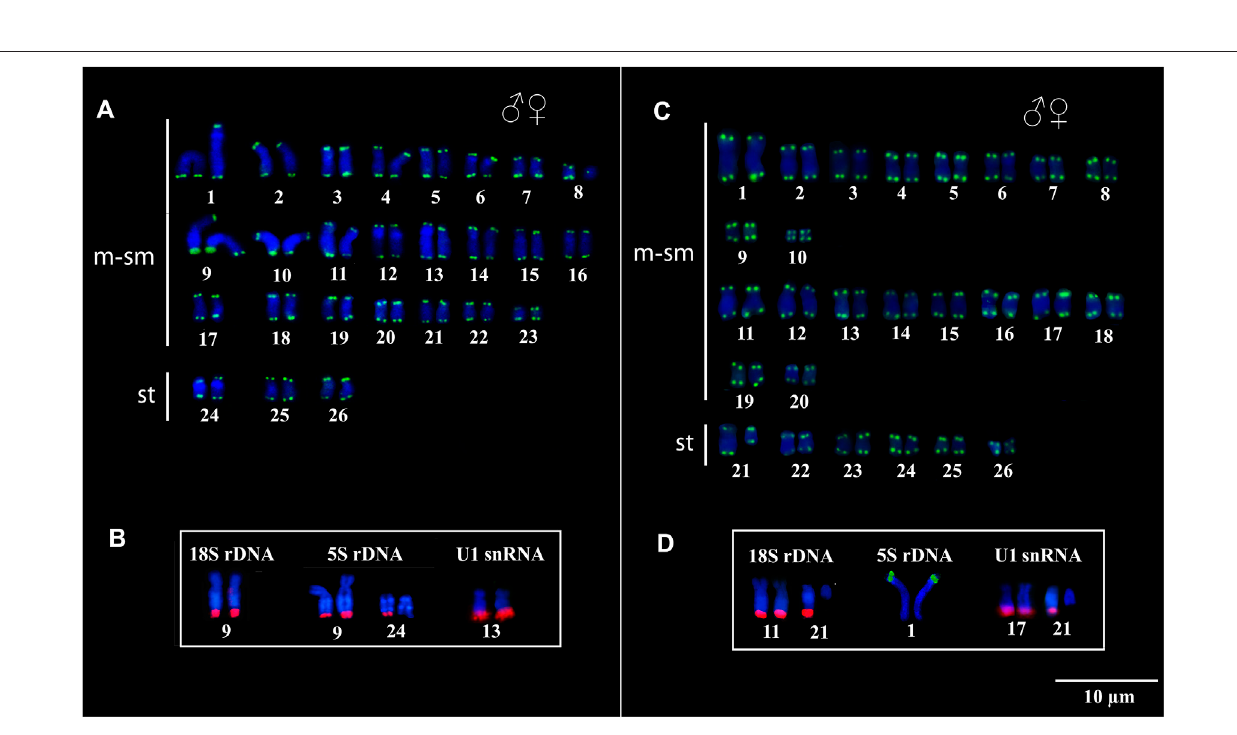
Frontiers in Genetics |